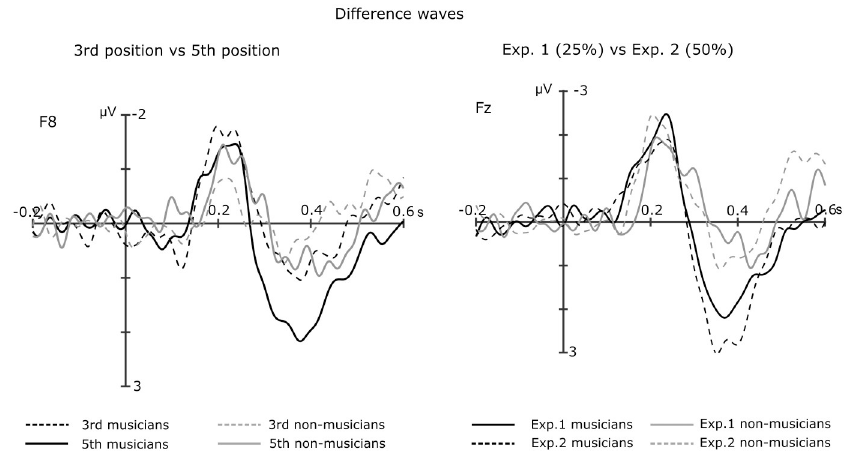
Fig 4. Difference waves the ERPs of musicians and non-musicians. Left panel: Difference wave comparing chords at the 3rd versus the 5th position. Right panel: Difference wave comparing Experiment 1 (where dissonant endings occurred with a probability of 25%) versus Experiment 2 (where dissonant endings occurred with a probability of 50%).